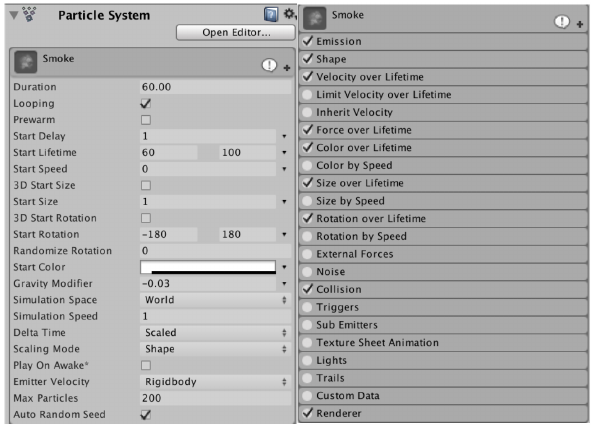
Figure 5. Particle system modules in